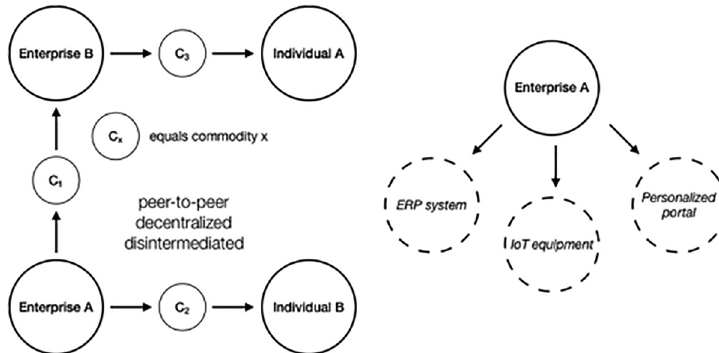
Figure 1. Supply and demand relationship in